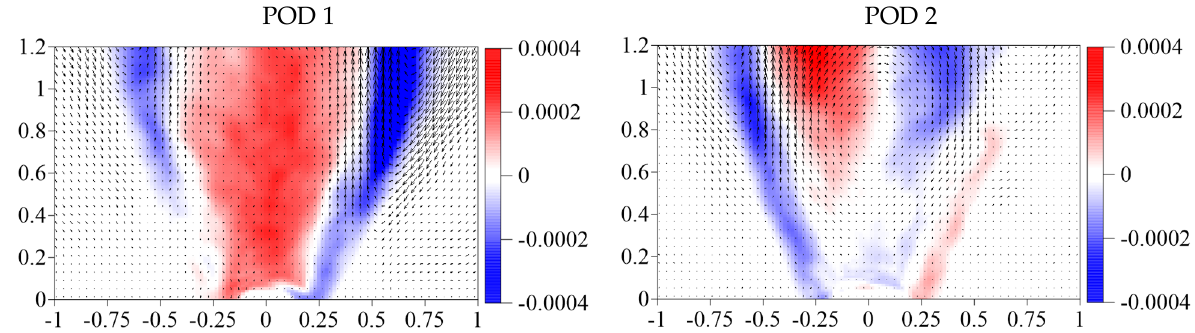
Figure 14. The first and the second POD modes with the conditionally sampled CO 2 concentration: the first line—1 atm. 293 K; the second line—2 atm. 500 K; the third line—3.4 atm. 500 K.